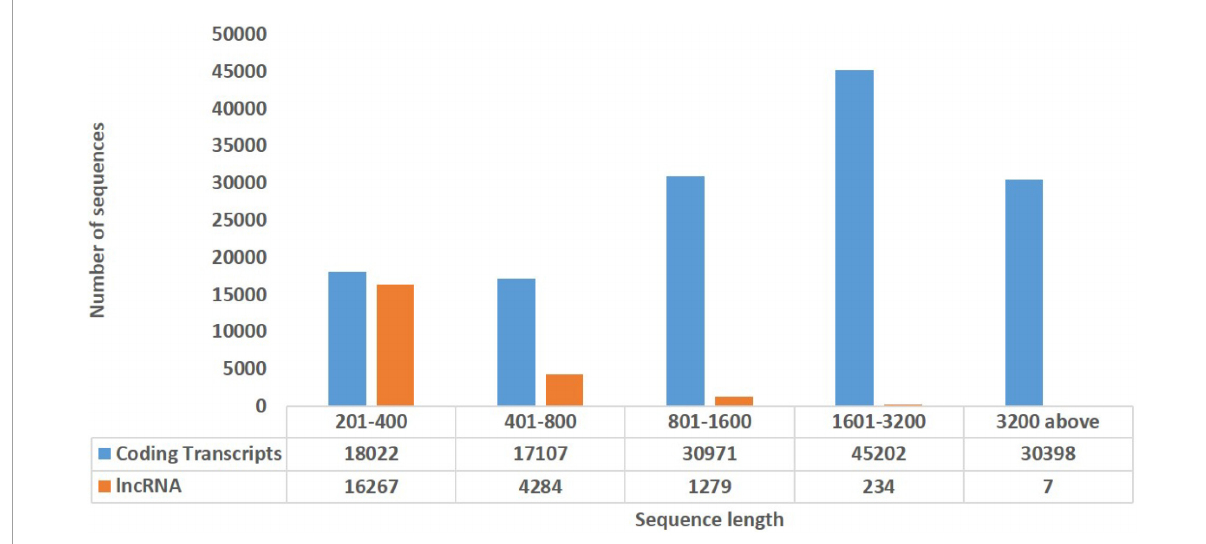
FIGURE2 Distribution of sequences present in coding transcripts and lncRNA based on their